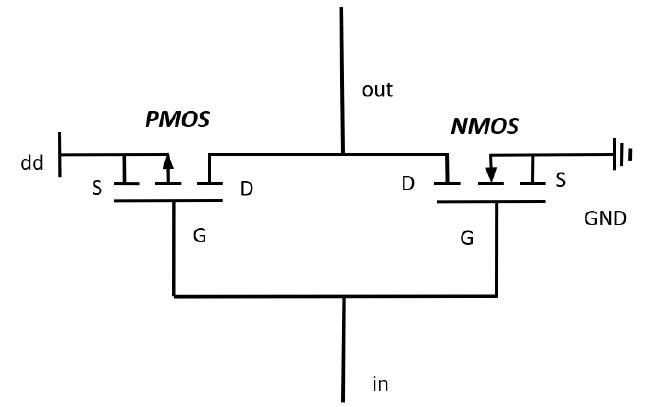
Figure 4. Schematic diagram of the CMOS inverter structure.